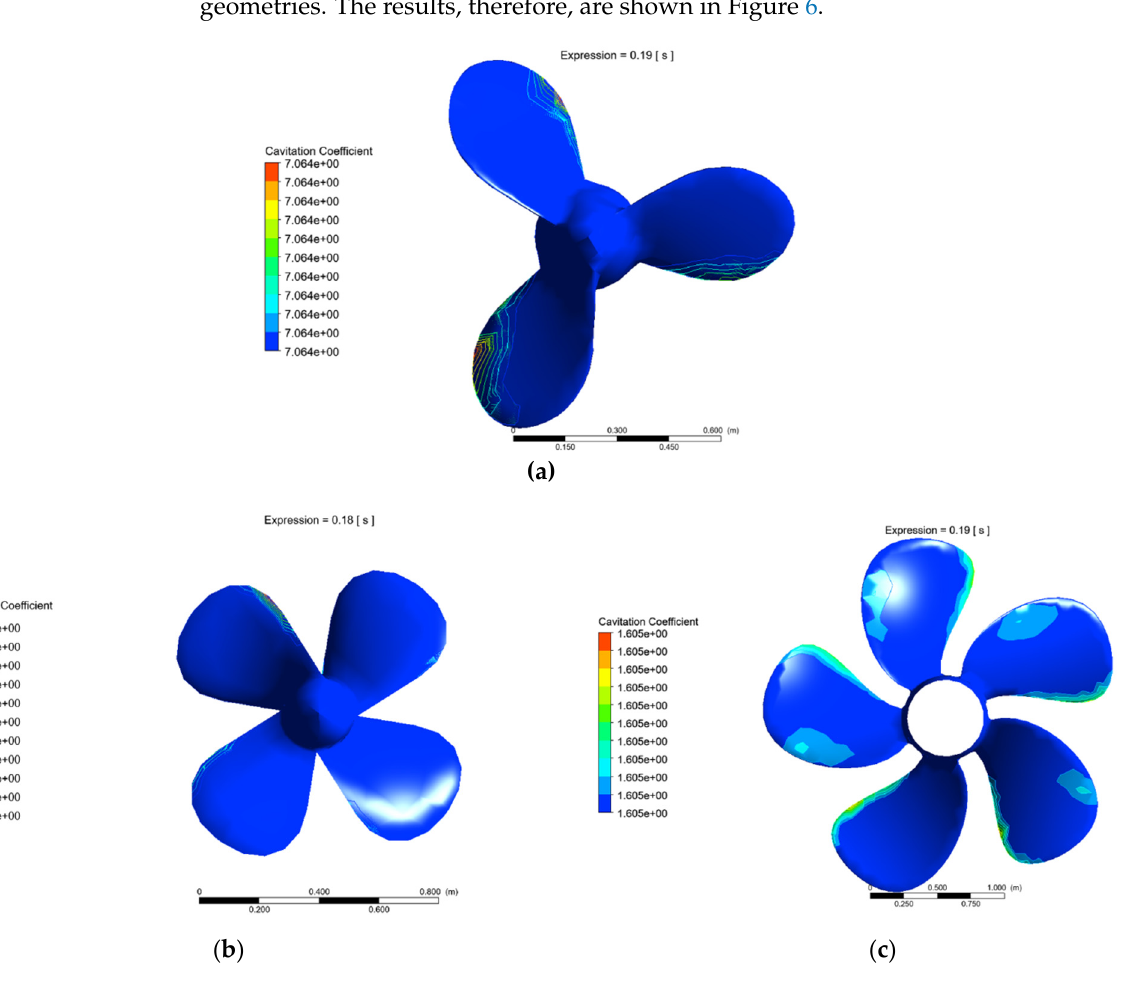
Figure 5. Vorticity magnitude in the vorticity region (i.e., tip-vortex region) as a source of sound on the blade and 5d downstream the propeller: ( a ) three blades, ( b ) four blades, and ( c ) five blades.